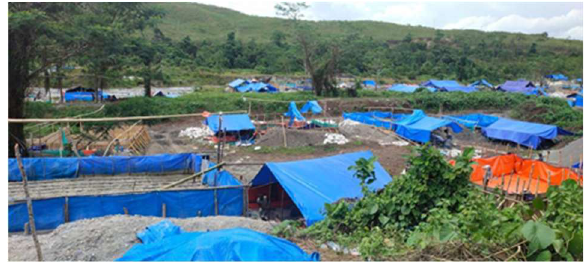
Figure 4. Illegal ASGM location in Buru Island, Maluku Province.